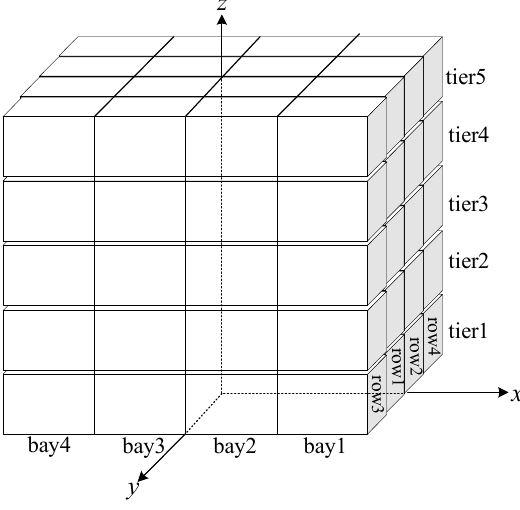
Figure 12. Ship coordinate system.